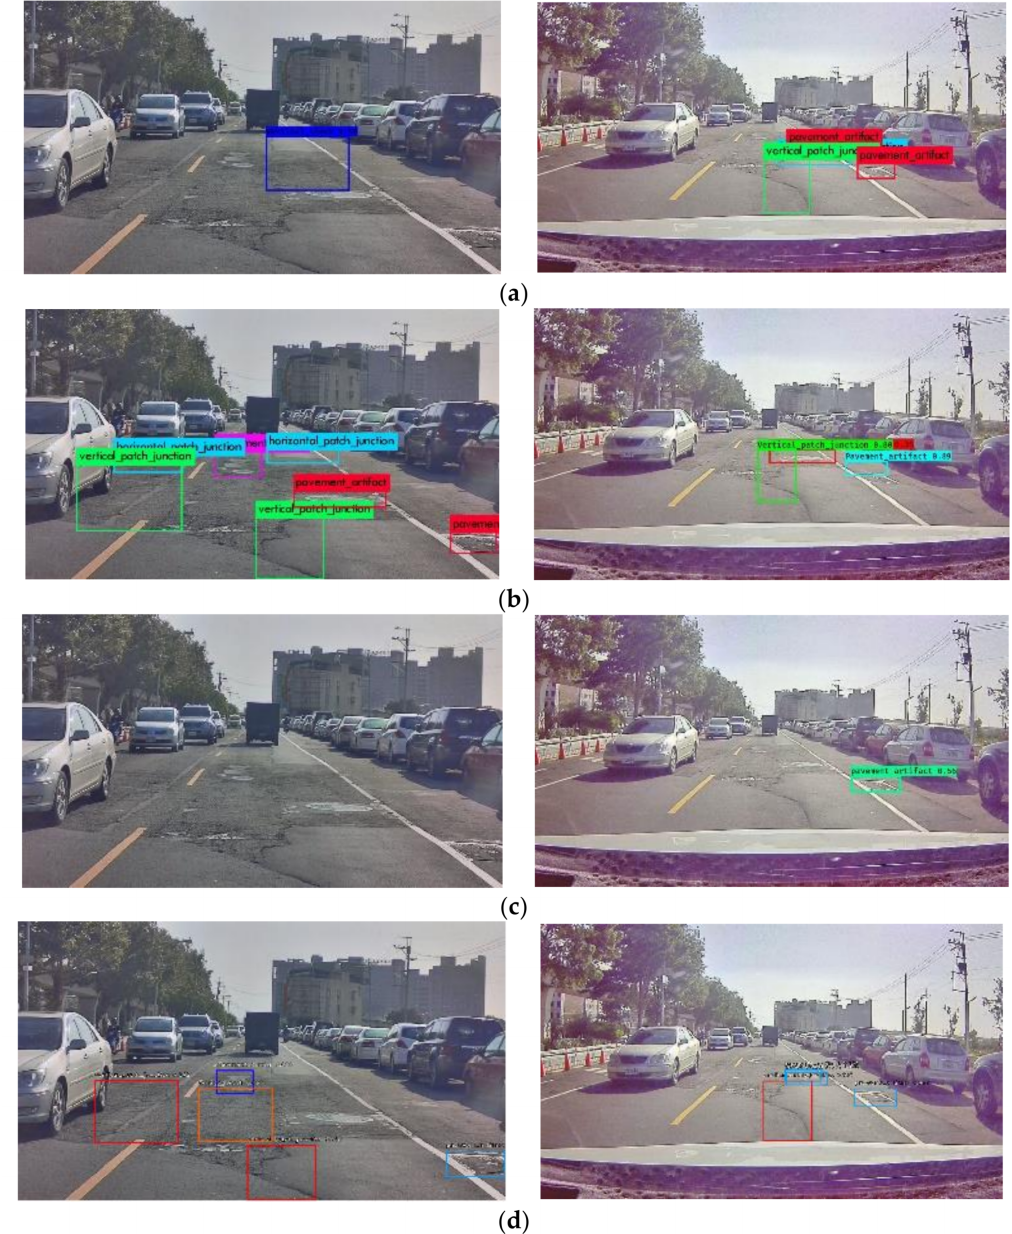
Figure 12. Pavement defect detection results using different deep learning models. ( a ) YOLOv4; ( b ) YOLO-mobilenet; ( c ) TF-YOLO; ( d )